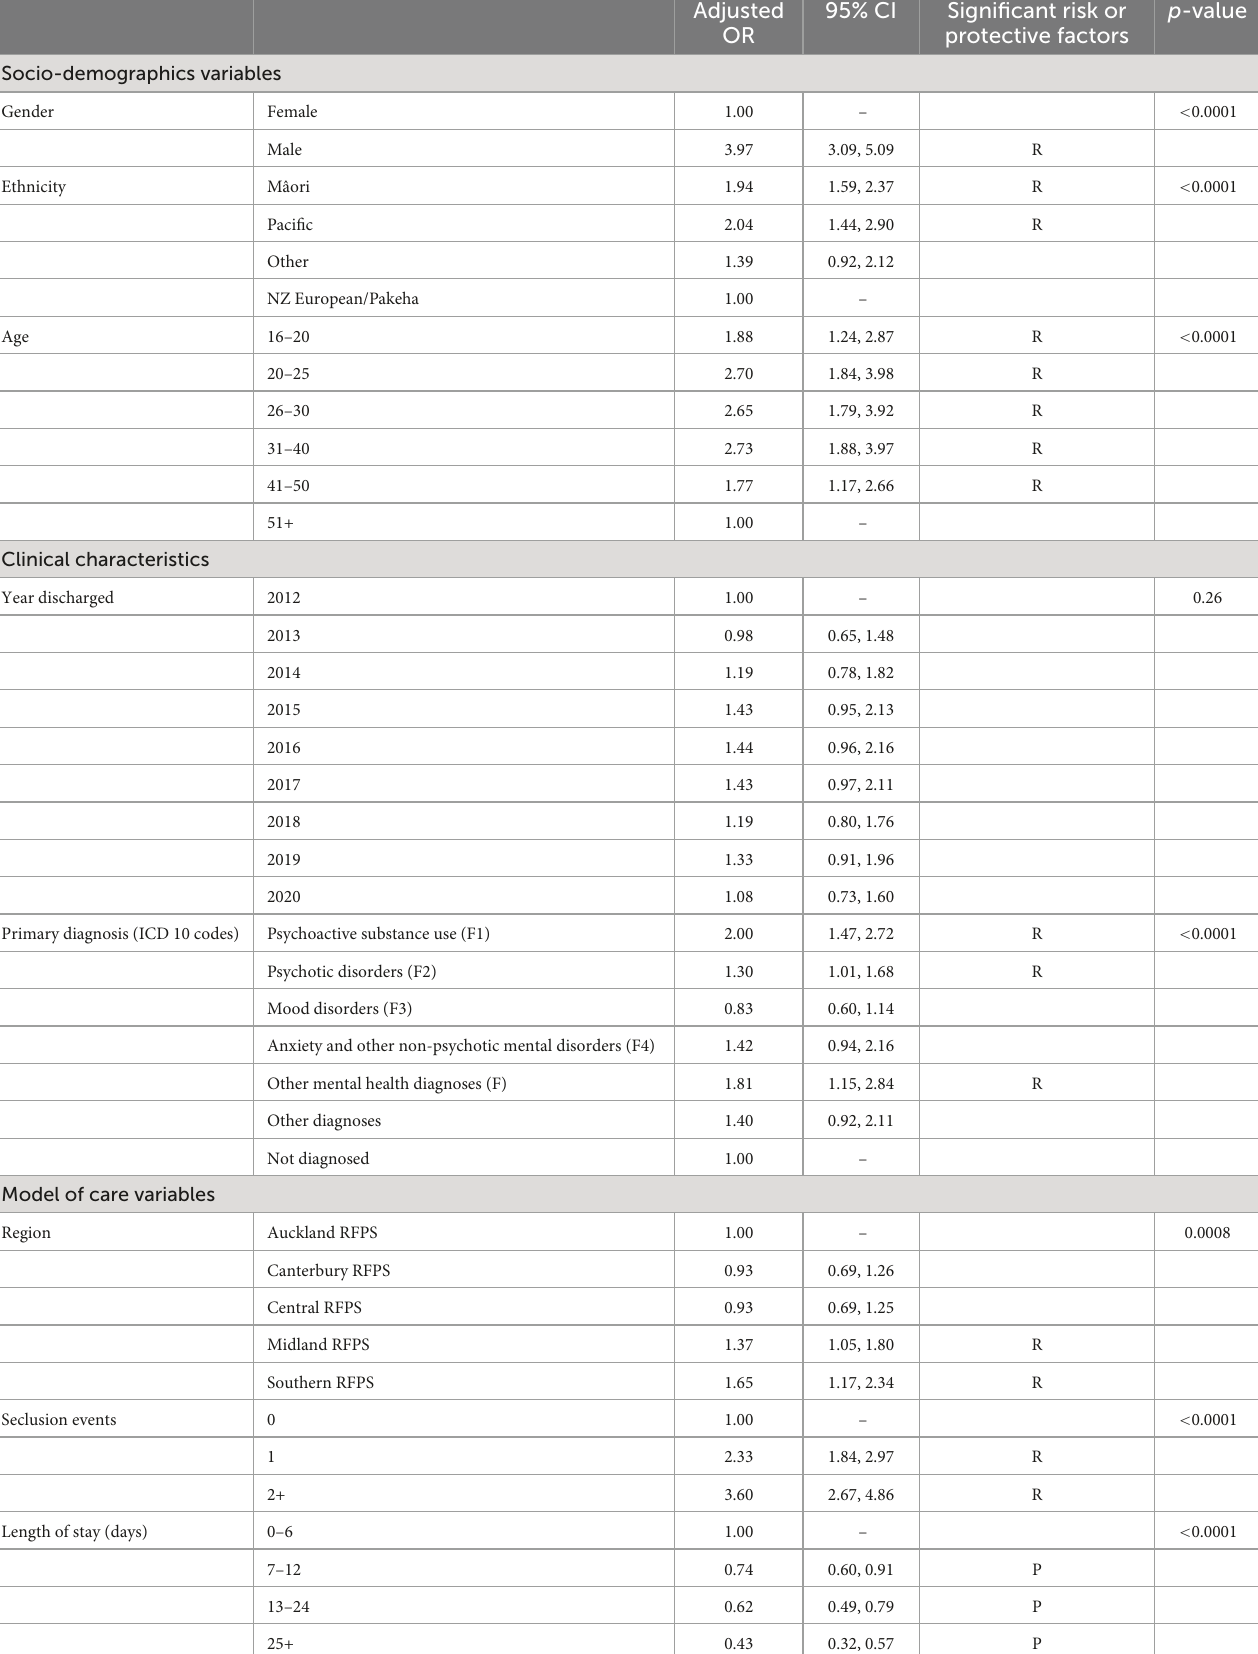
TABLE 4 Final multiple variable model for custodial remand within 28